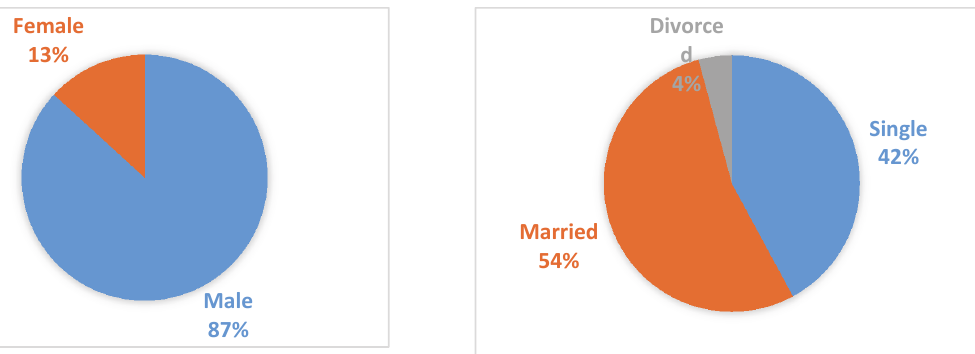
Fig. 2. Gender distribution chart Fig. 3. Marital status distribution